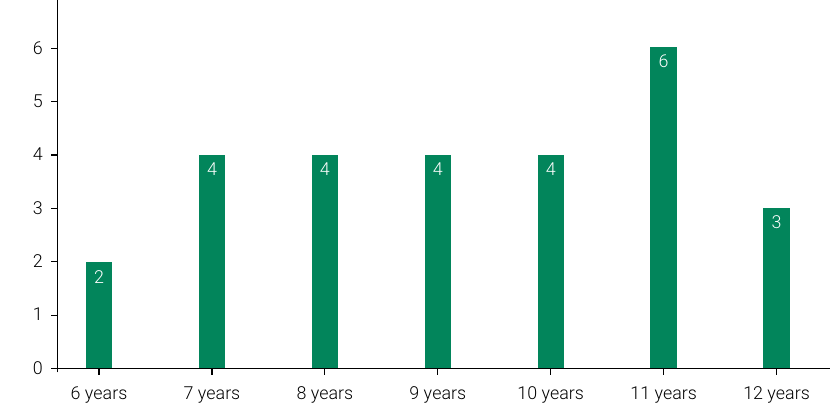
Figure 2. Number of schoolchildren affected by traumatic events by